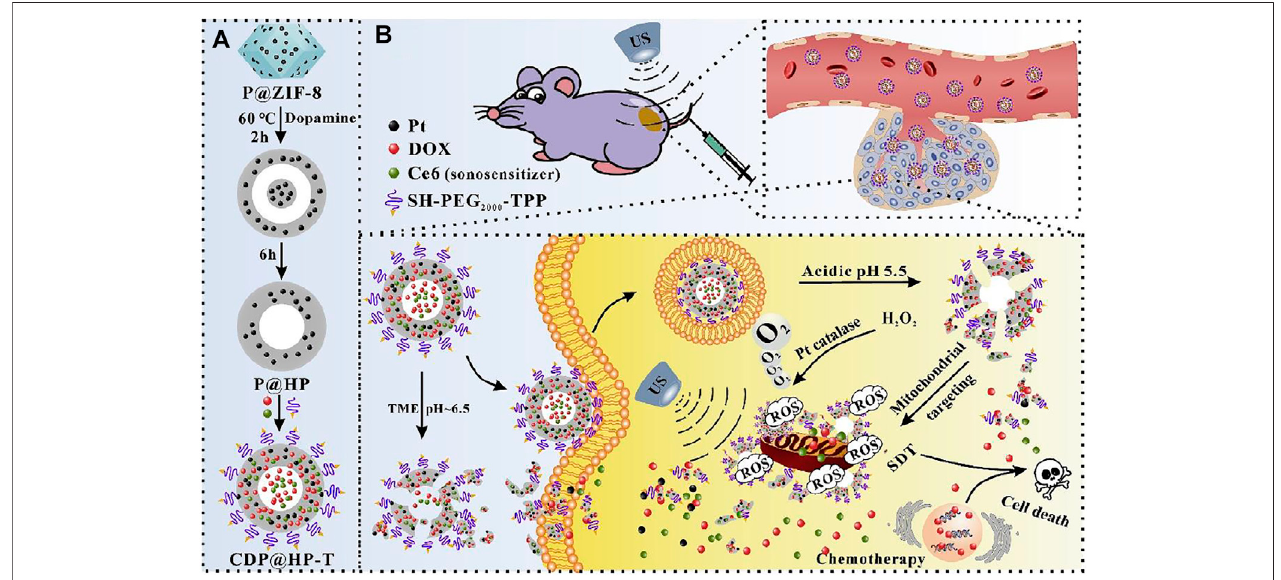
FIGURE5| Schematic illustration ofthesynthesis route ofCDP@HP-T (A) and chemo-sonodynamiccombinedtherapy. (B) Reproduced with permission from An et al. (2020). Copyright (2020) Elsevier.